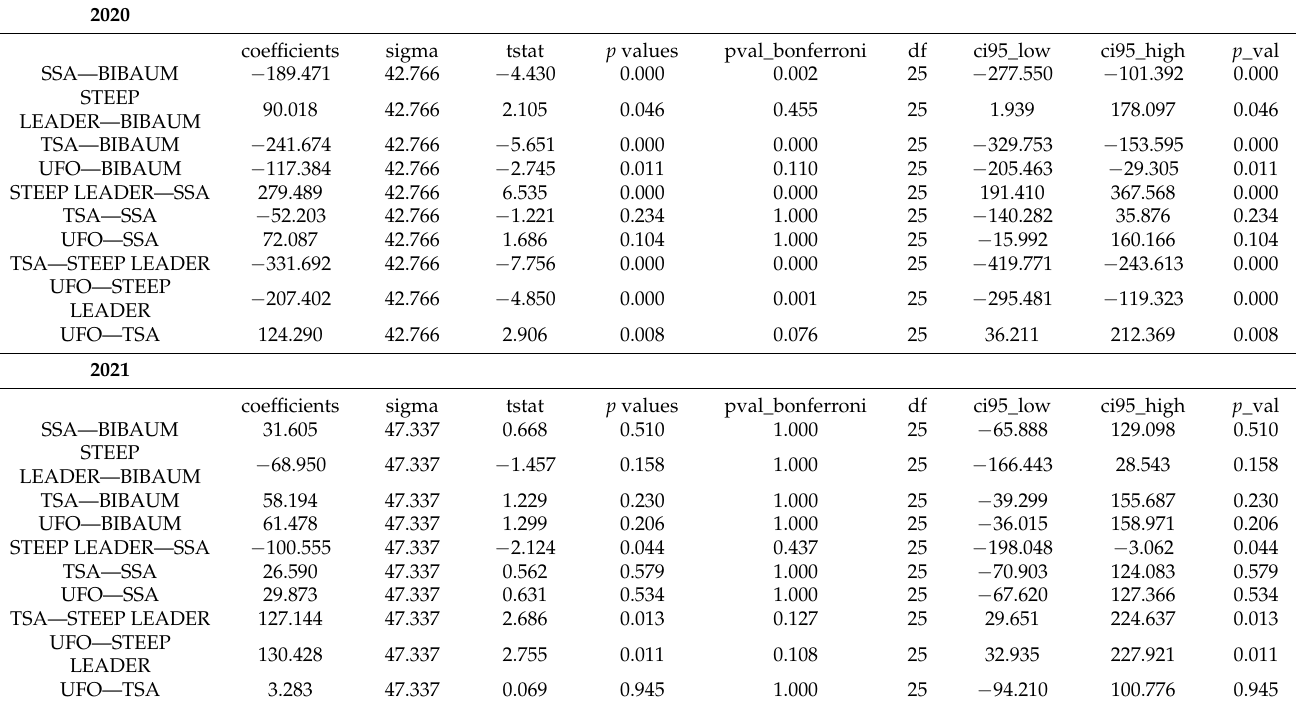
Table A3. Stem pull